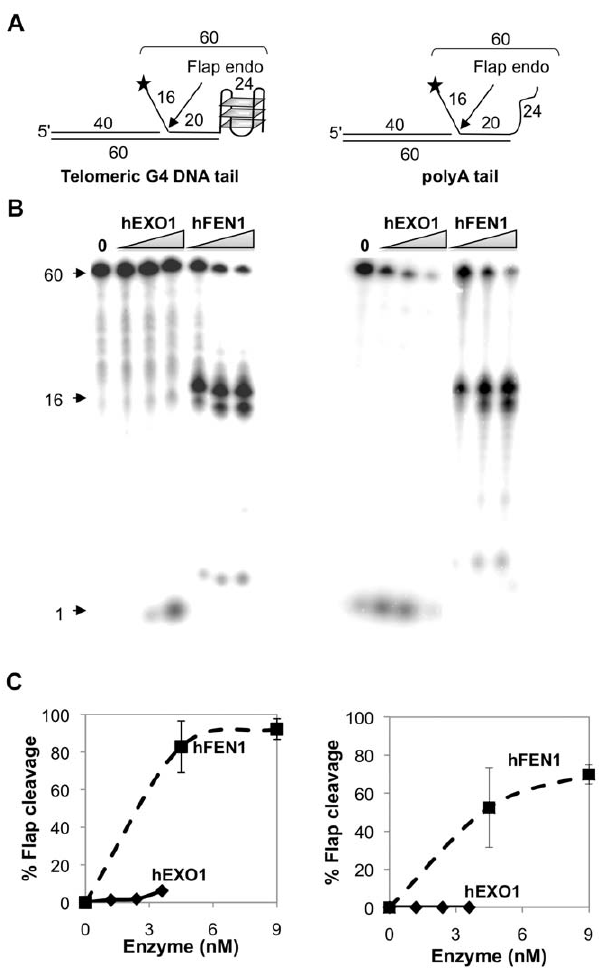
Figure 2. A 3 9 G4 DNA tail inhibits flap endonuclease activity of hEXO1 but not hFEN1. (A) Diagram of substrates bearing a 5 9 flap and 3 9 telomeric G4 DNA or polyA tails. Lengths of oligonucle- otides, flaps, duplex regions and 3 9 tails are indicated; asterisks denote 5 9 end-label. (B) Products of digestion of substrates shown in Panel A by hEXO1 (0, 1.2, 2.4 and 3.6 nM) and hFEN1 (0, 4.5, 9.0 and 18 nM). Arrows indicate 60 nt 5 9 -labeled DNA substrate, 16 nt flap cleavage product, and 1 nt exonucleolytic cleavage product. (C) Quantitation of flap cleavage activity of hEXO1 (0, 0.6, 1.2 and 2.4 nM; diamonds) and hFEN1 (0, 4.5, 9 and 18 nM; squares) on substrates shown in Panel A.